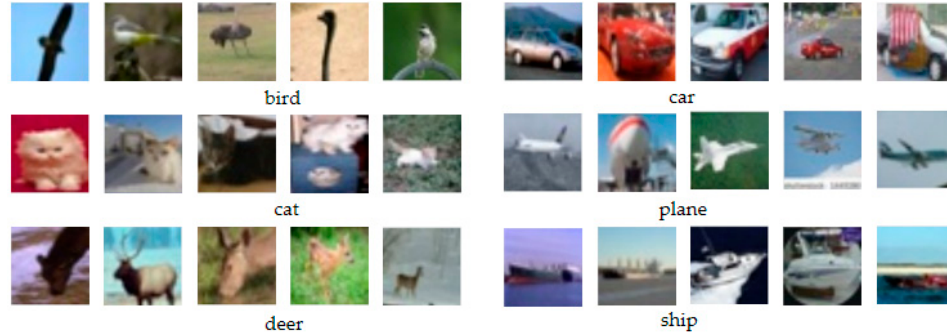
Figure 1. Some samples of the CIFAR-10 database.